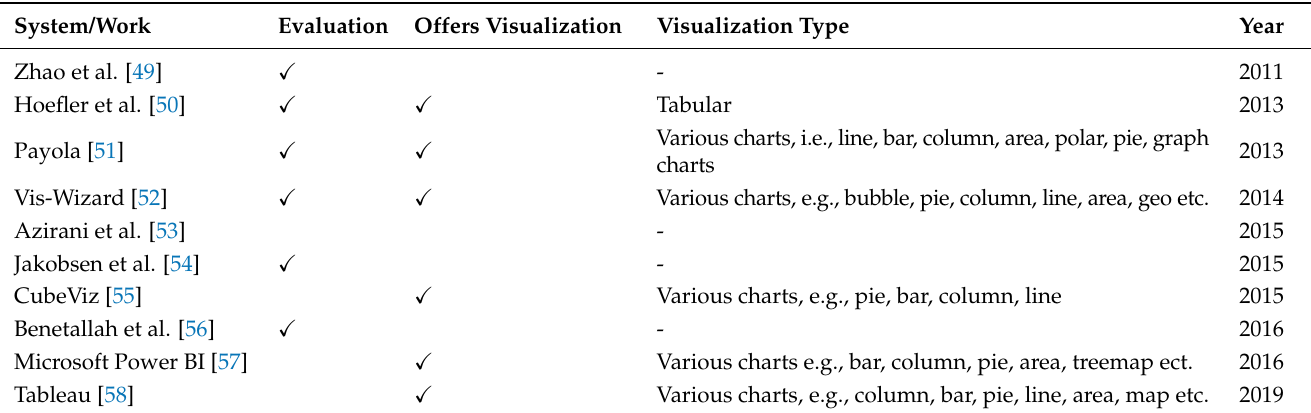
Table 2. Overview of Approaches and Systems for Category C2 (analytical queries